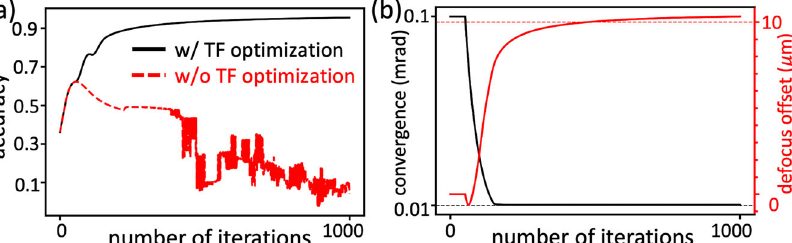
Fig. 4 AD phase retrieval with partial recovery of the transfer function. a Evolution of the accuracy during AD phase retrieval with (black) and without (red) TF optimization. b Evolution of the recovered convergence semi-angle (black) and offset of the defocus values (red) during AD phase retrieval with TF optimization. The dashed lines mark respectively the ground truth for the two parameters.